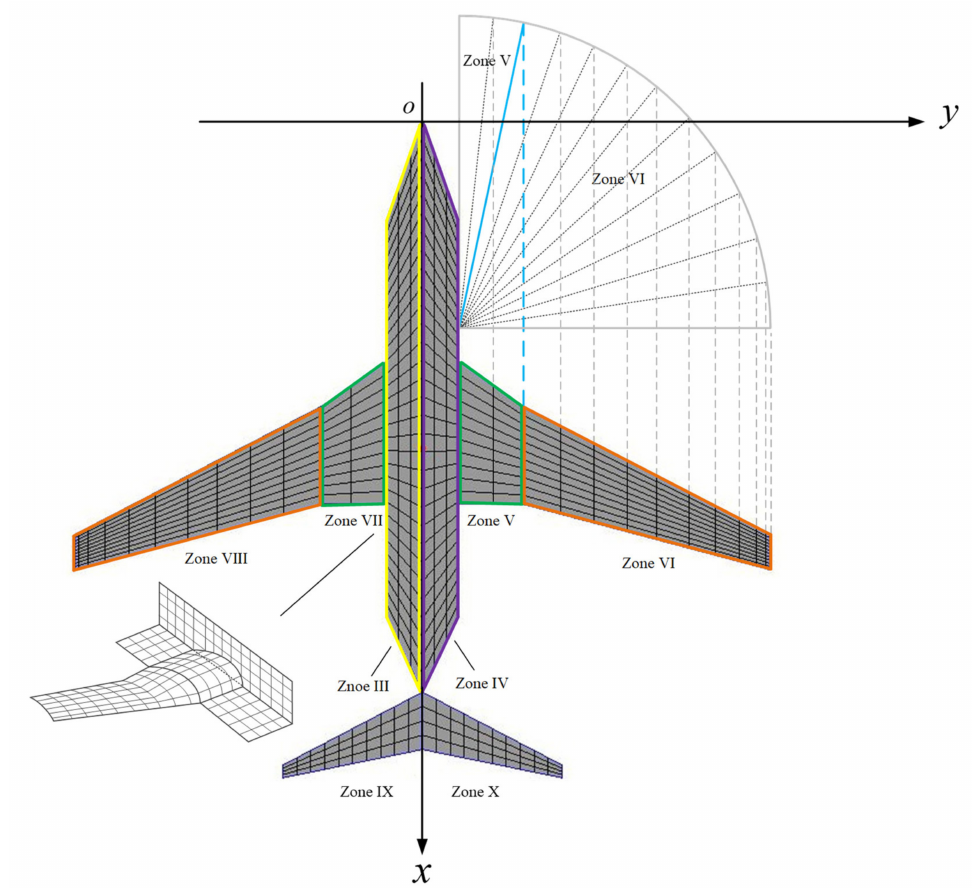
Figure A2. Grid division of the